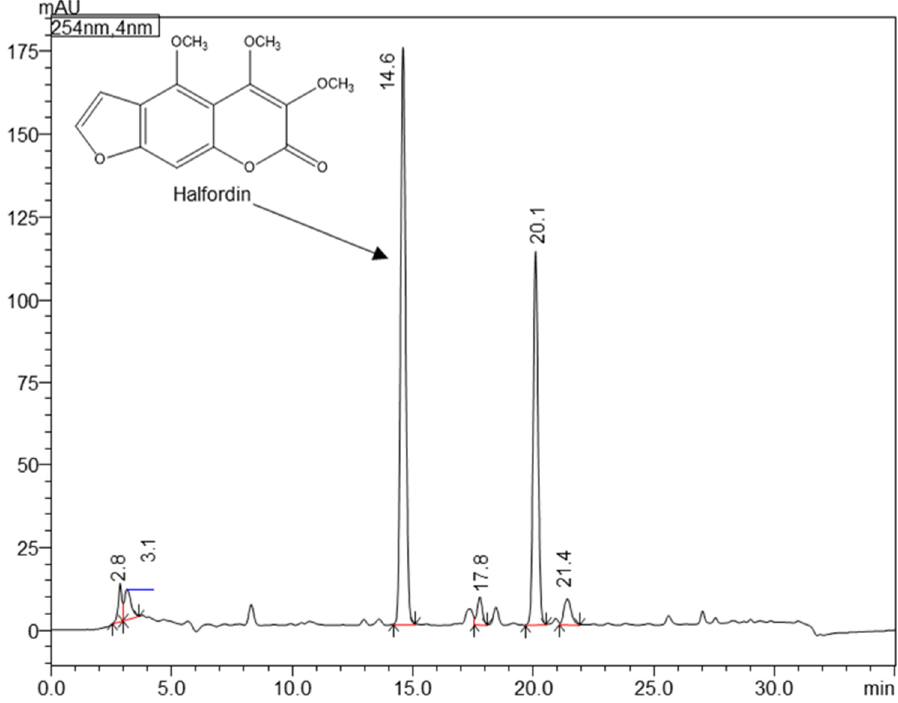
Figure 1. HPLC-DAD chromatogram of the H. kendack methanol leaf extract with the main com- pound halfordin marked (detection 254 nm; Phenomenex Gemini NX-C18 110A (250 mm × 4.6 mm, 5 µ m, Warsaw, Poland); 1 mL/min, gradient of water and methanol. Peak rf = 14.6: halfordin, peak rf = 20.1: unidentified alkaloid. Table 1. Partition coefficient (K D ) values of halfordin from the H. kendack methanol leaf extract in different volume ratios of n -hexane/ethyl acetate/methanol/water (HEMWat). No.